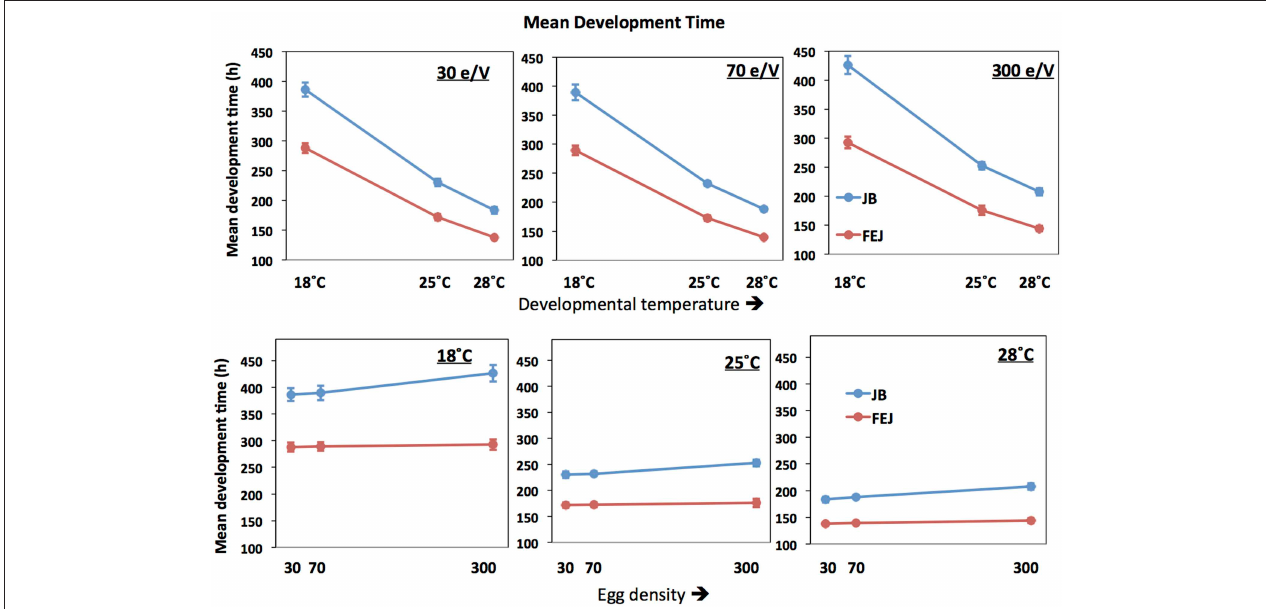
FIGURE 1 | Mean pre-adult development time of FEJ and JB populations. The upper panel shows mean trait value plotted across temperature for each treatment density (e/V = eggs per vial). The lower panel shows mean trait value plotted across egg density for each treatment temperature. The error bars show 95% confidence intervals calculated from the variation among replicate populations in each combination of selection regime, temperature, and density.